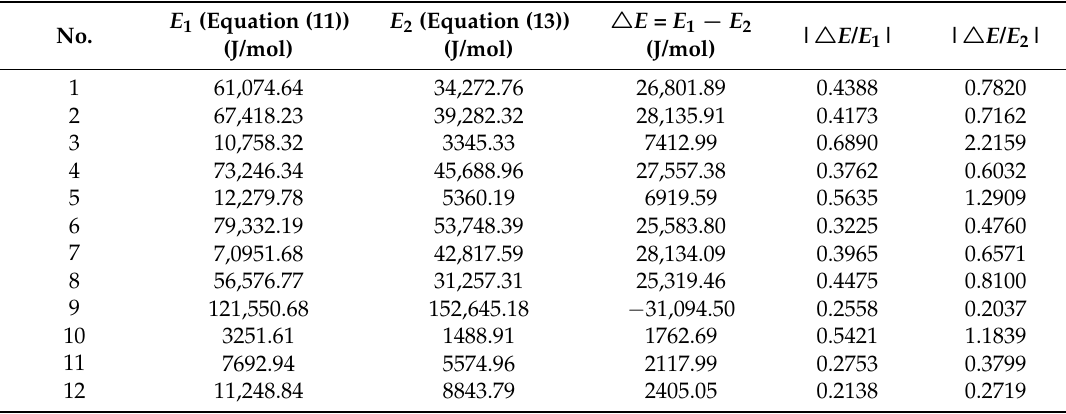
Table 3. The comparison of E values with the forty-one mechanism functions at a 10% oxygen concentration.